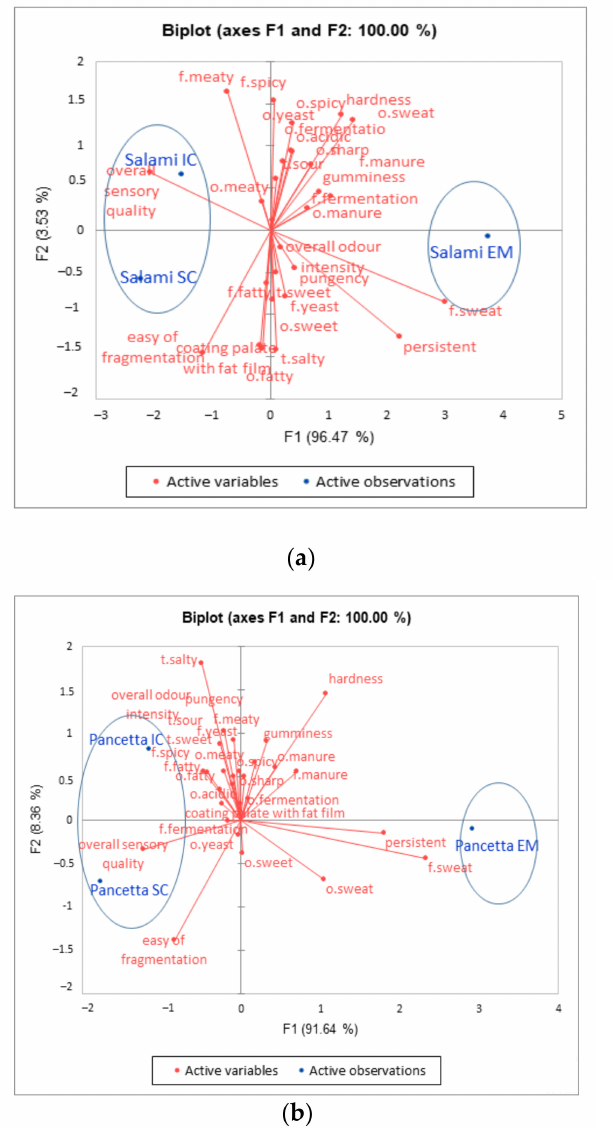
Figure 3. Principal component analysis (PCA) of the EM, IC and SC salami ( a ) and pancetta ( b ) sen- sory attributes. EM = entire males; IC = immunocastrates; SC = surgical